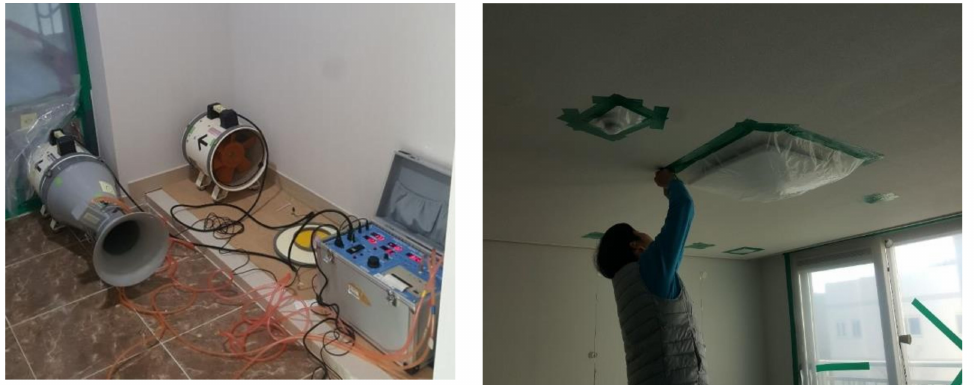
Figure 2. Blower door tester and sealing work in the